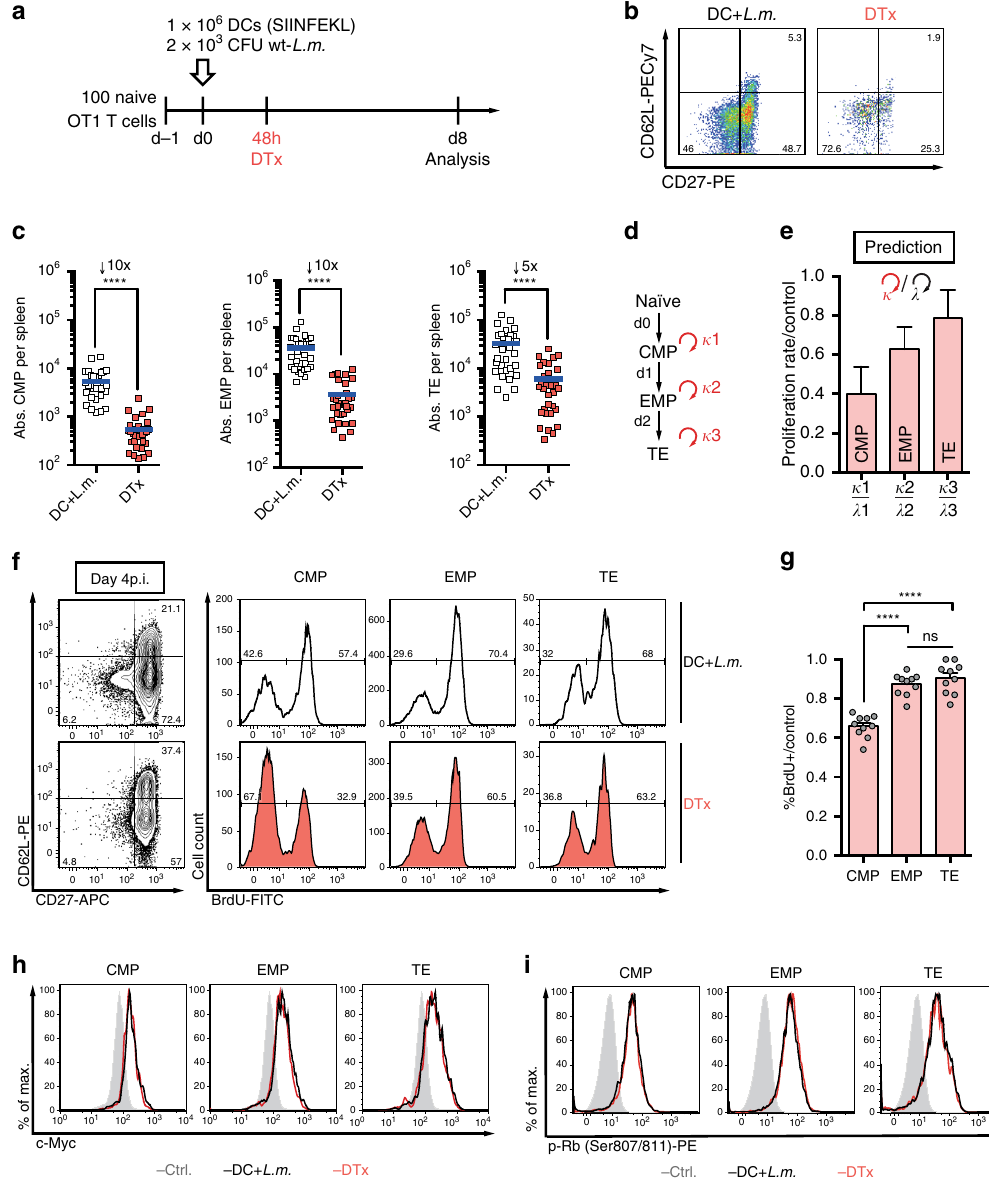
Fig. 3 Depletion of antigenic stimuli leads to a pronounced delay in cell cycle progression of CMPs. a Scheme of the experimental setup and DC depletion strategy. b , c Progenies were recovered from spleen per transferred 100 OT1 cells at day 8 after immunization ( n = 30), as well as following DTx treatment at 48 h ( n = 32). b Representative pseudo-colour plots showing expression of CD62L and CD27 for transferred T cells. c Scatter plots depict absolute numbers of CMP, EMP and TE cells. d Adjusted model used for fi tting to the experimental data, characterized by altered proliferation rates ( κ 1 – κ 3 ), effective 12 h after DTx treatment. e Bar graph depicts predicted proliferation rates, relative to those of the untreated control group. f , g BrdU labelling was performed as in Fig. 2e, but with DTx treatment at 48 h. f Representative contour plots showing the expression of CD62L and CD27 on transferred T cells, with corresponding histograms showing the BrdU pro fi les for the indicated subsets. g Bar graph depicts the percentage of BrdU + -cells relative to the mean of the untreated control group ( n = 10). h , i Representative histograms show expression of ( h ) c-Myc and ( i ) retinoblastoma protein (Rb) phosphorylated at Ser807/811 (grey: endogenous naïve CD8 + T cells) for transferred OT1 cells at day 4 p.i. Lines indicate the mean, error bars the s.e.m.**** P < 0.0001 (Mann – Whitney test). Data are compiled from four ( b , c ), two ( f , g ) or one of two independent experiments ( h , i ). Source data are provided as a Source Data fi